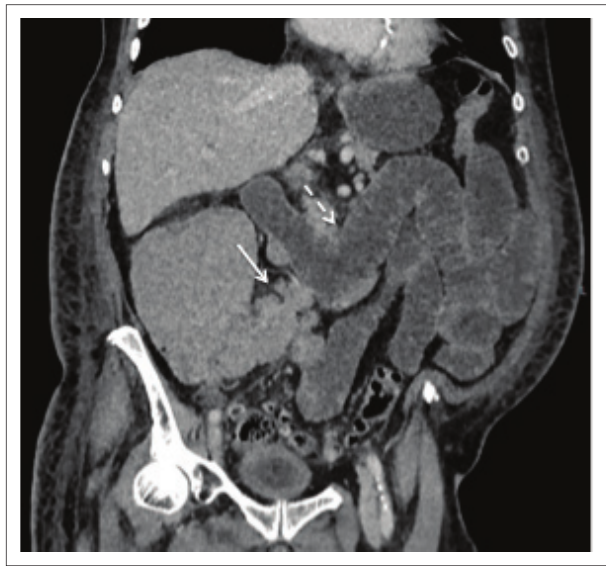
FIGURE 2: Coronal reconstruction of portovenous phase enhancement of a 50-year-old male (as Figure 1), demonstrating enlarged lymph nodes along the ileocaecal vessels (solid arrow) and upstream fluid-filled loops of small bowel (dashed arrow).